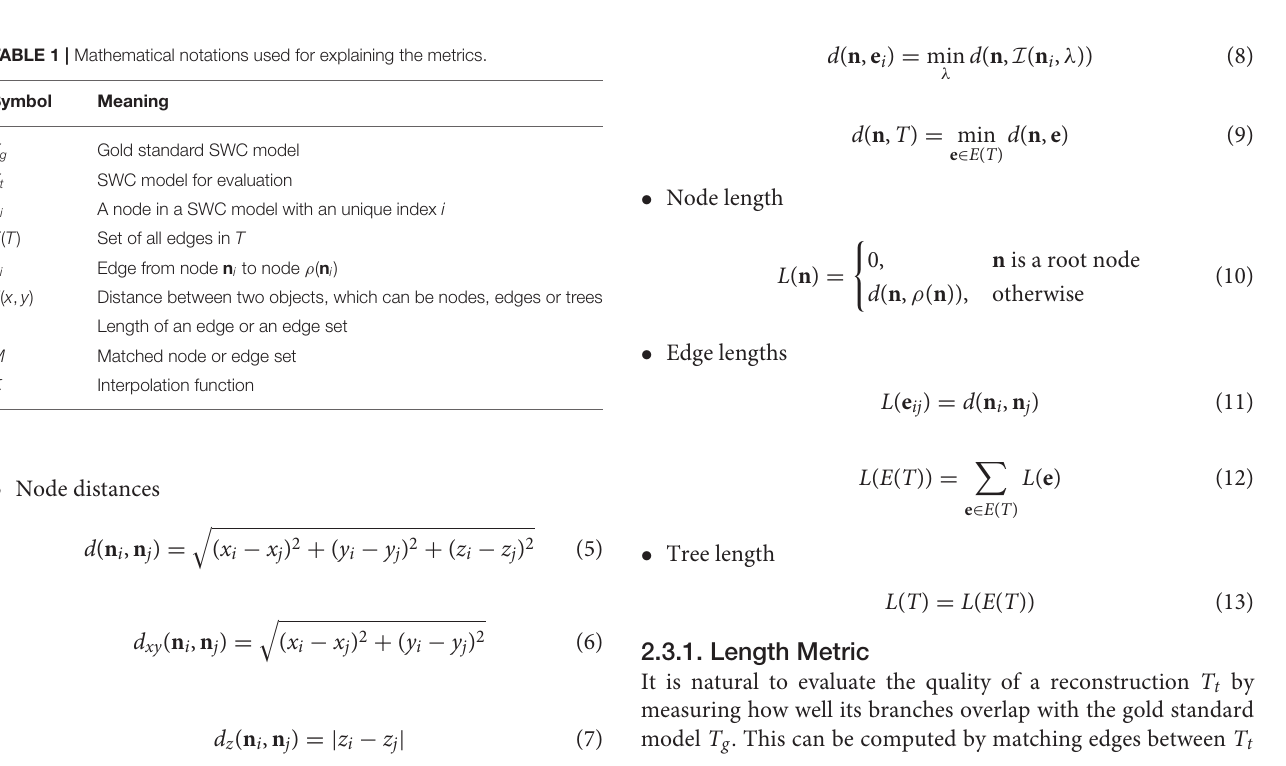
TABLE 1 | Mathematical notations used for explaining the